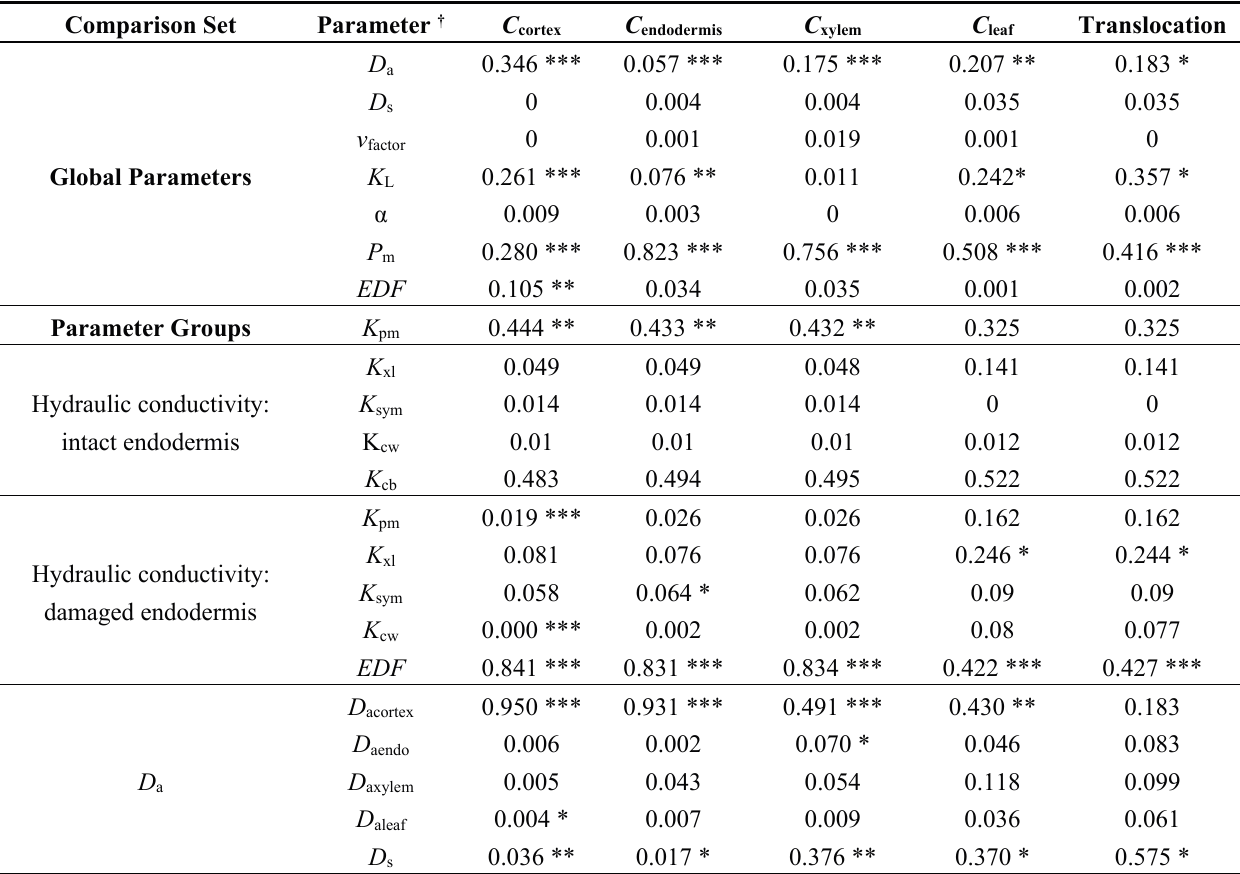
Table A1. Sensitivity coefficients for global, grouped and specific parameter comparison sets analyzed using Latin Hypercube